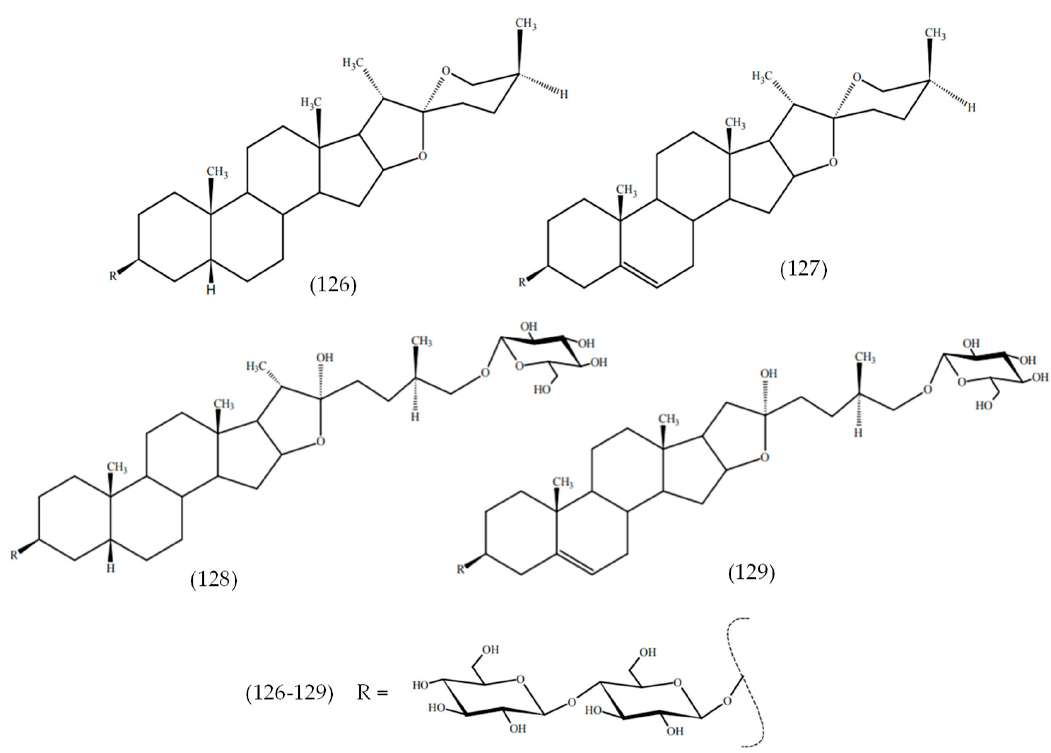
Figure 18. Structures of compounds reported in Veronica beccabunga L.